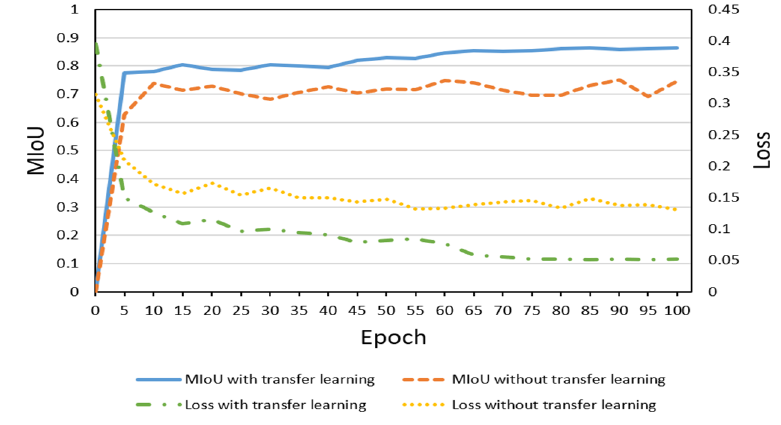
Figure 10. The performance effect of transfer learning on WRDeepLabV3+.